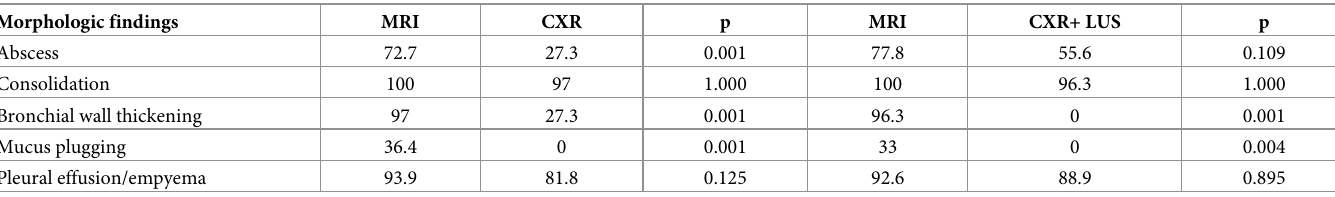
Table 4. Prevalence of morphologic findings in MRI and CXR at baseline.